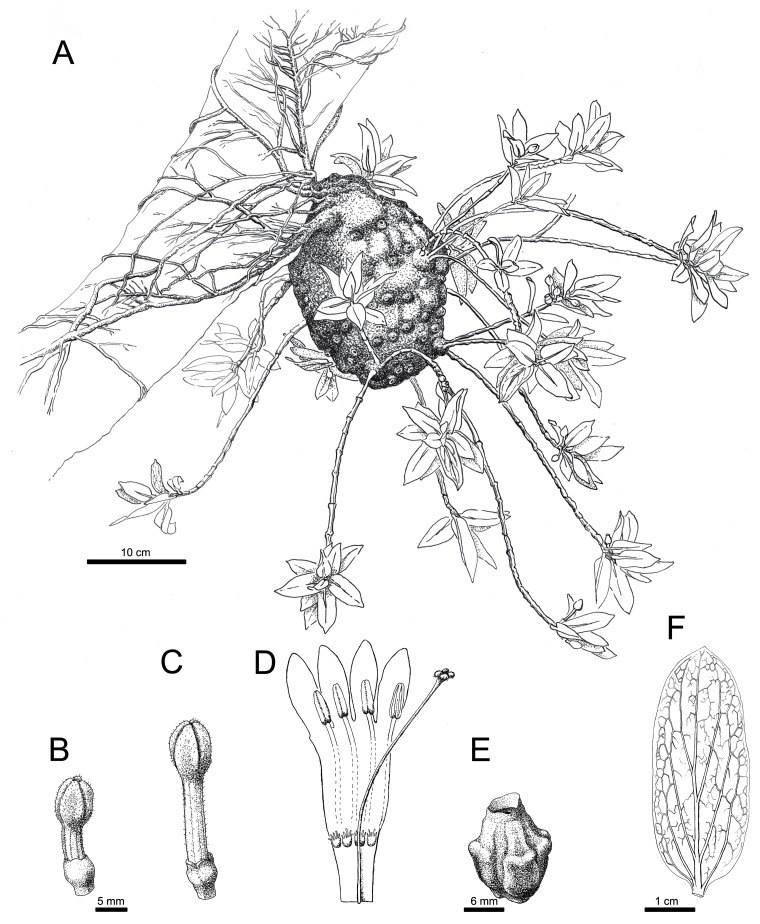
Squamellaria huxleyana Chomicki, spec. nov.(A) Habit showing the domatium. (B, C) Successive stages of flower bud opening, showing the corolla tube elongation. (D) Open corolla tube with the four squamellae. (E) Fruit with a bilobed-quadrangular shape in cross section. (F) Leaf, showing the festooned brochidromous venation (connecting to other secondary veins via multiple loops and not reaching the margin).